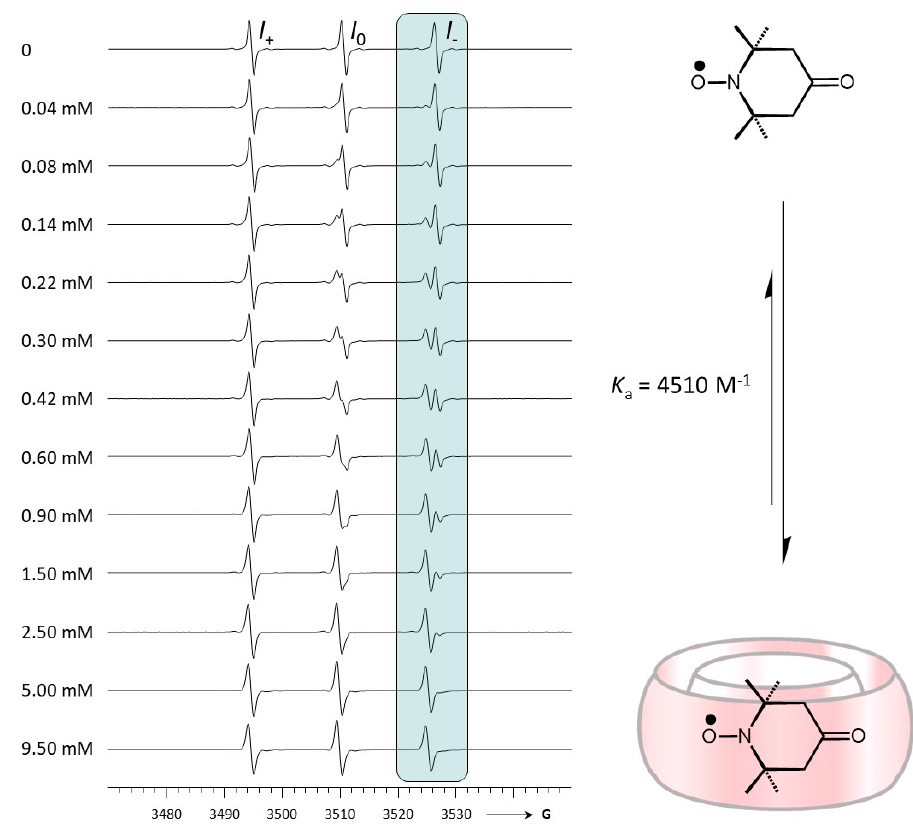
Figure 1. EPR titration of TEMPONE (0.1 mM) with CB[7] (concentration on the left) in water and proposed inclusion complexation (right).